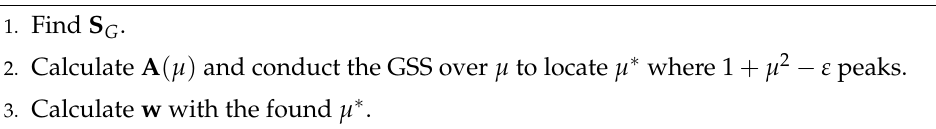
Algorithm 1 : AP pre-coder optimization